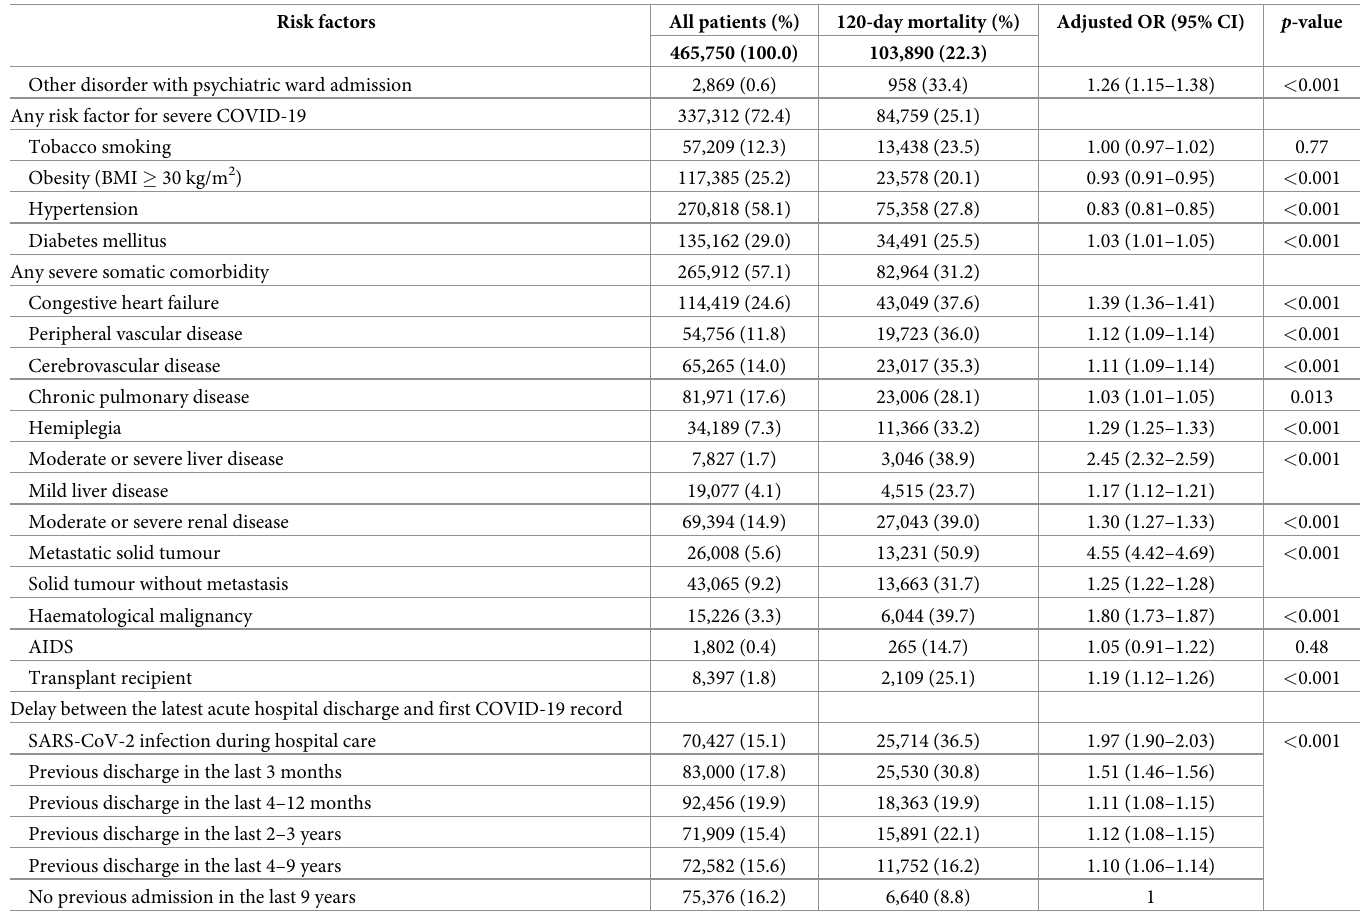
first and second blue bars). In patients without mental disorders, 15,513 (95% CI, 14,679 to 16,347) of 56,907 COVID-19-related deaths may have been avoided overall without COVID- 19 caseload surges in hospitals (excess mortality risk of +5.0% [95% CI, 4.7 to 5.2] for a pre- dicted risk of 13.3% [95% CI, 13.2 to 13.4] at baseline). Patients with preexisting mental disorders were recorded with more prognostic factors for COVID-19-related mortality than others ( Tables E and F in S1 Text ) that involved a worse mortality risk predicted at baseline in all periods ( Fig 2 , comparison of first blue and first red bars). COVID-19 caseload surges in hospitals were even more negatively associated with indi- vidual prognosis in patients with mental disorders compared to others ( Fig 2 , comparison of second blue and second red bars). In patients with mental disorders, 14,343 (95% CI, 13,622 to 15,064) of 46,983 COVID-19-related deaths may have been avoided overall without COVID- 19 caseload surges in hospitals (excess mortality risk of +9.3% [95% CI, 8.9 to 9.8] for a pre- dicted risk of 21.2% [95% CI, 21.0 to 21.4] at